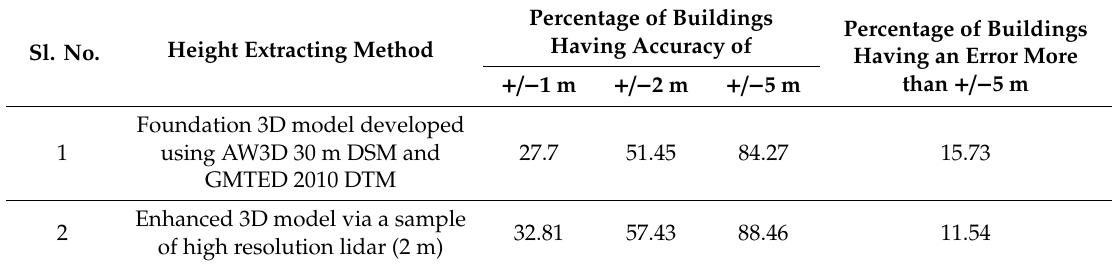
Table 3. Validation results showing percentage of buildings within each interval before (foundation 3D model) and after accuracy enhancement (enhanced model), for Nottingham.